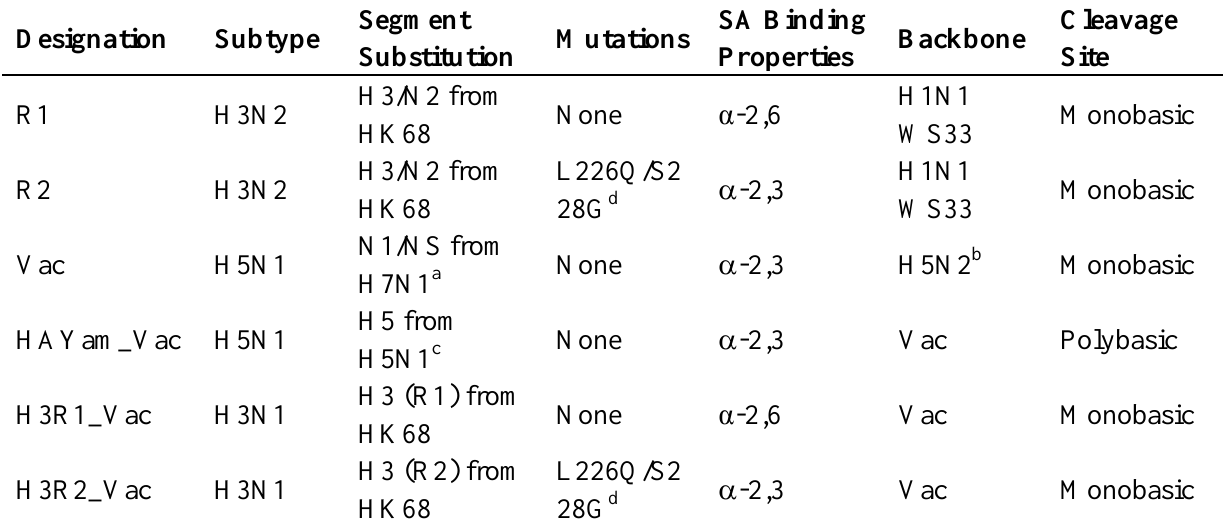
Table 2 . List of reverse genetic viruses used in this